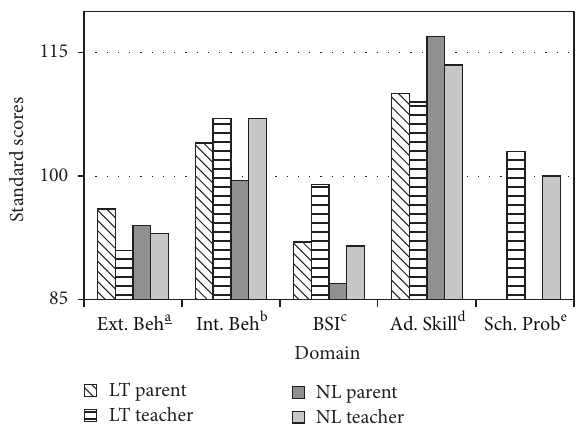
Figure 3: BASC-II parent and teacher scores between LT and NL groups. Higher standard scores represent greater perceived skill deficit, with the exception of adaptive skills, where lower scores represent poorer perceived level of functioning. a Externalizing behaviour. b Internalizing behaviour. c Behaviour Symptoms Index. d Adaptive skill. e School problems.